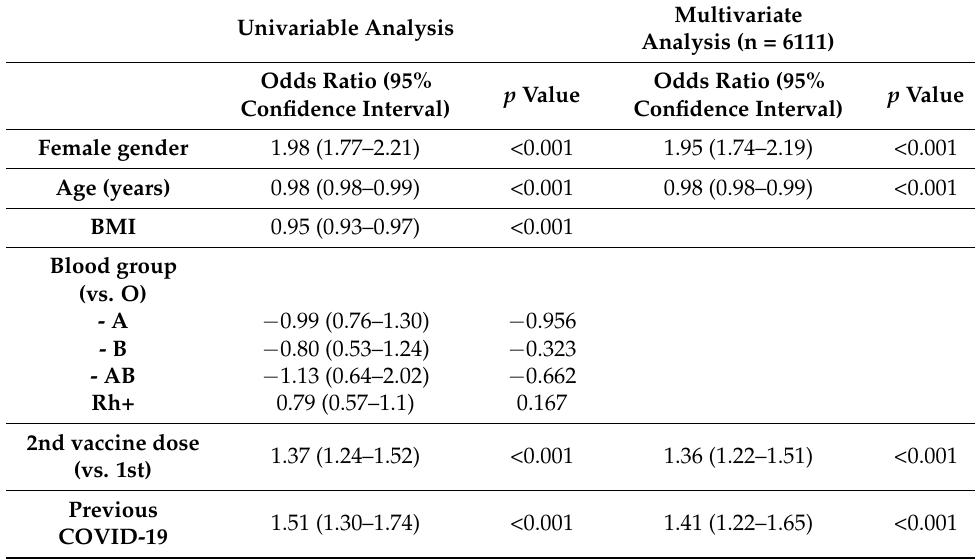
Table 2. Factors associated with the occurrence of any adverse events following SARS-Cov-2 vaccina- tion at univariate and multivariate analyses based on logistic